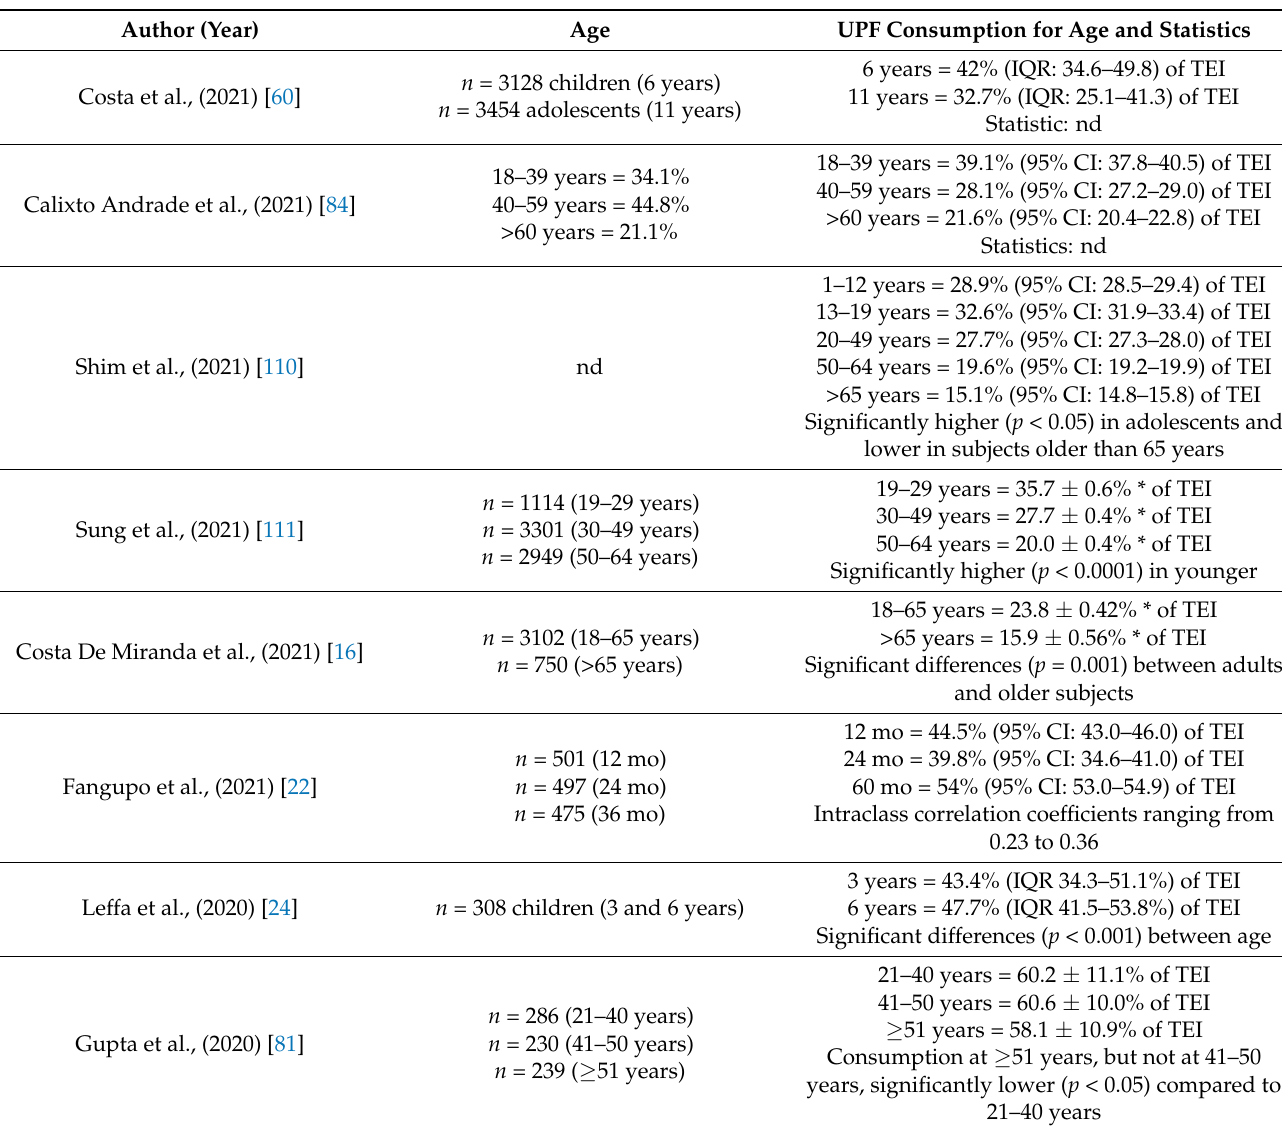
Table 3. Level of consumption of ultra-processed foods (UPF) expressed as percent energy provided by UPF intake with respect to total energy intake (TEI) by considering